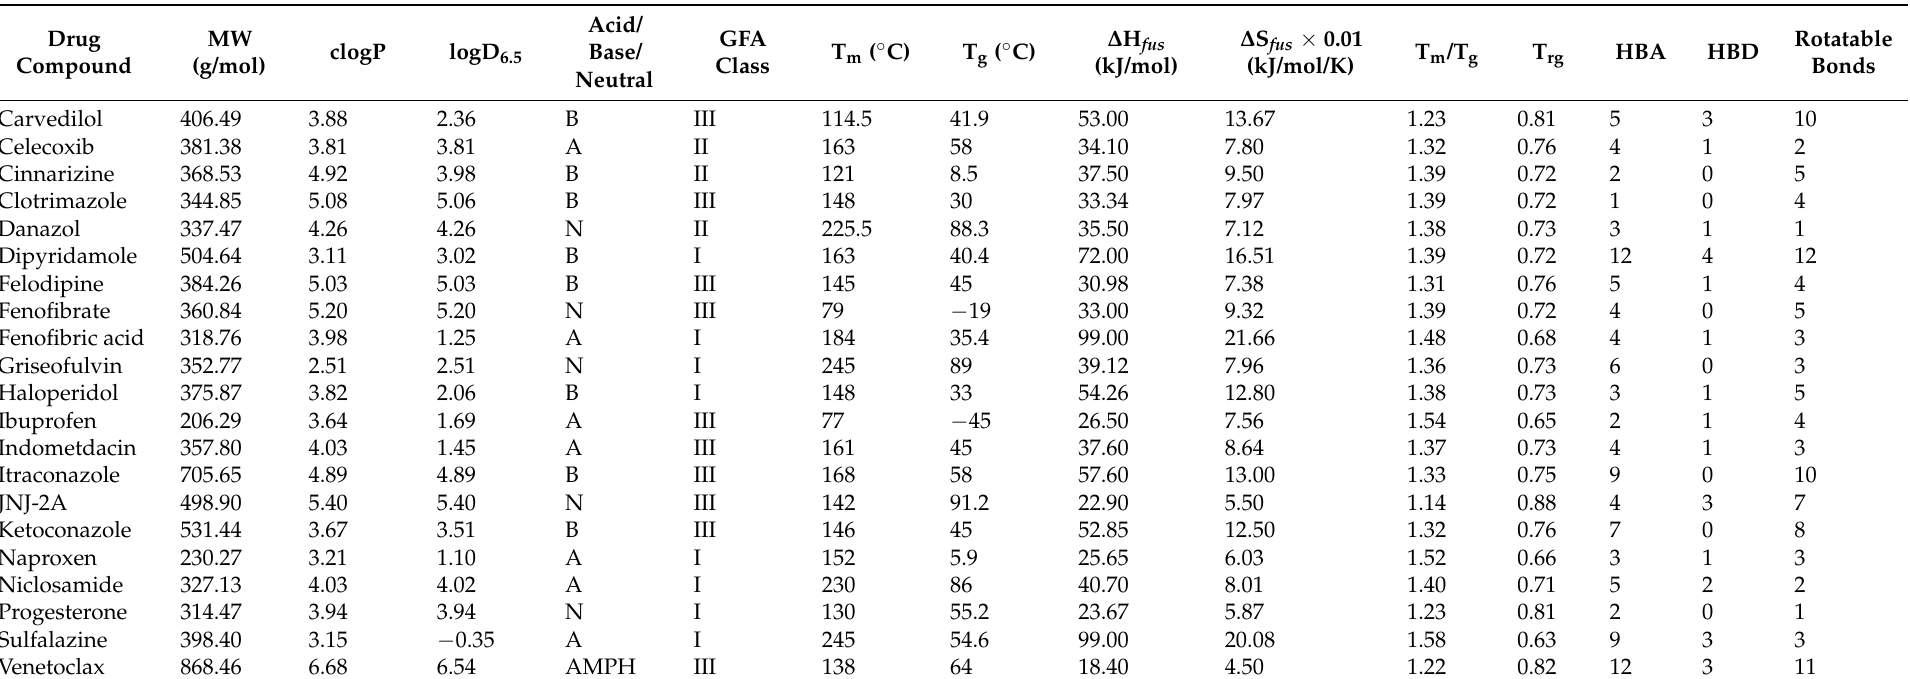
Table 1. Selection of the physicochemical and molecular properties of the investigated compounds collated from the literature, predicted from ADMET Predictor 9.5 or obtained experimentally using DSC. AMPH refers to